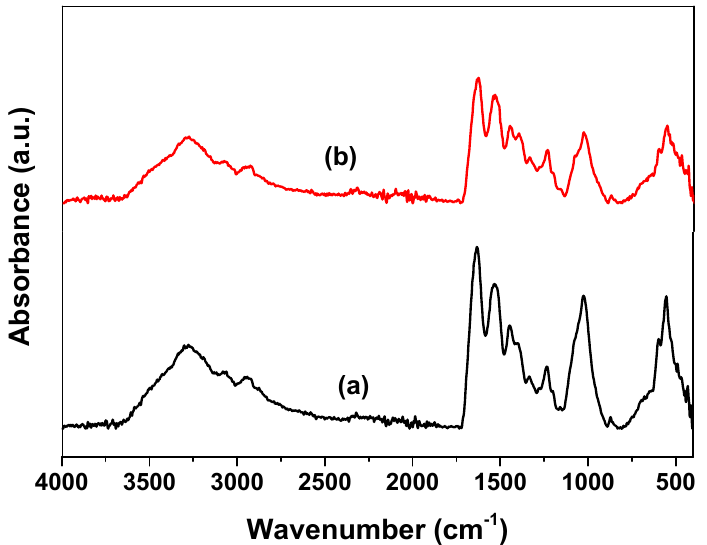
Figure 8. FTIR spectra of the powder fish scales before ( a ) and after 240 min of contact with AMD solution ( b ).